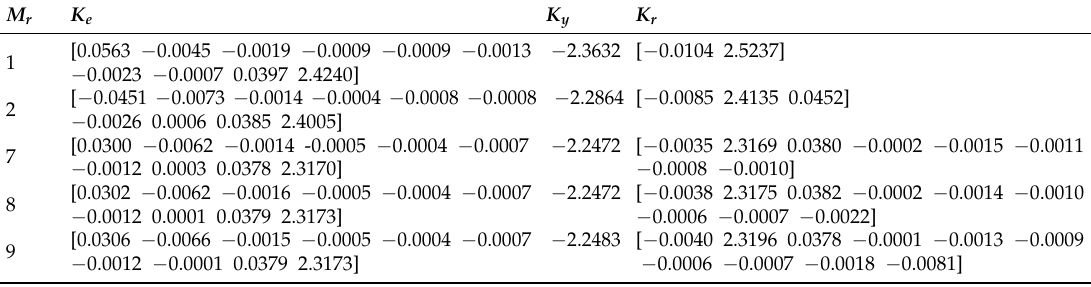
Table 1. Gain matrices with different preview length of M r .